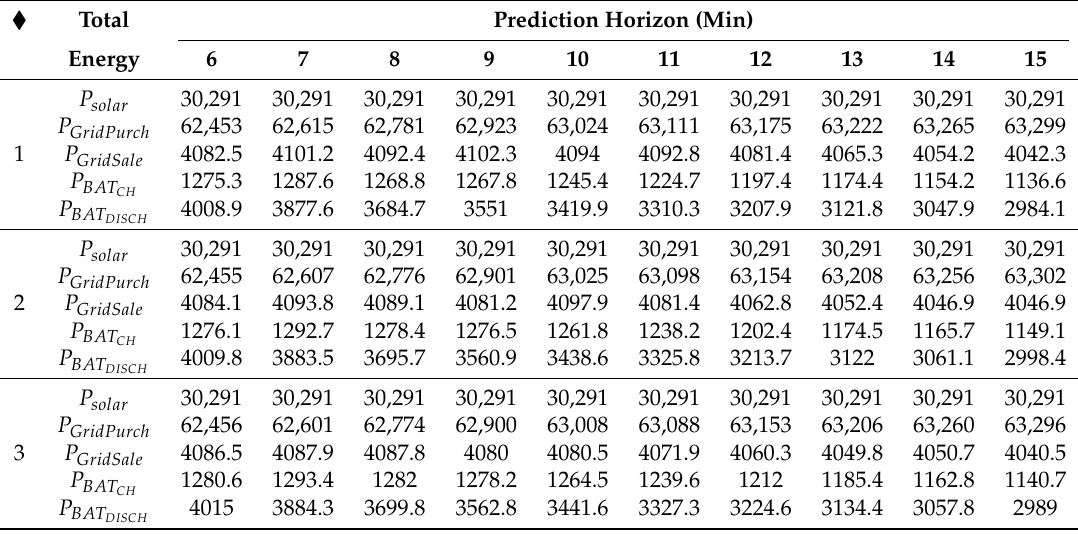
Table A2. Energy (kW) distributed for prediction horizons from 6–15 min with separation intervals of 1 min on a day with passing